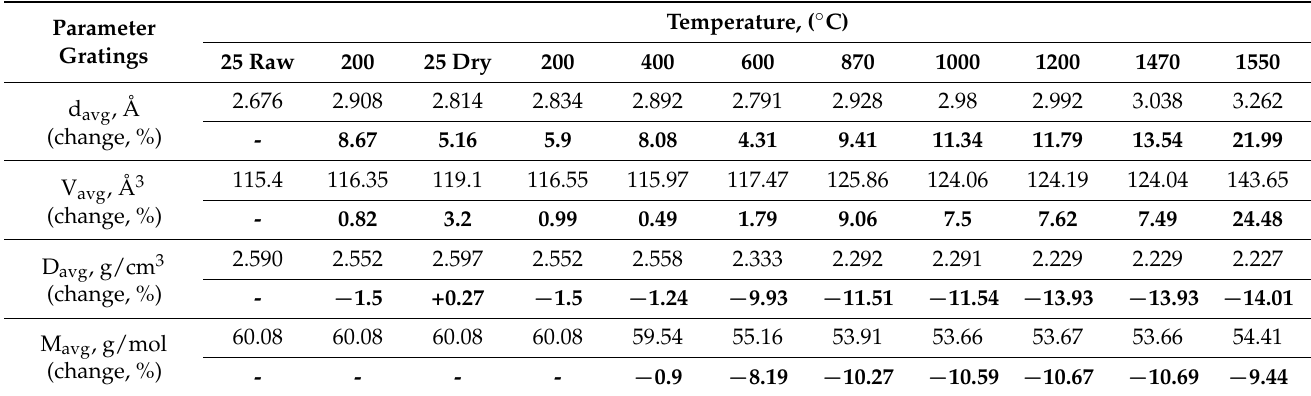
Table 6. Changes in the lattice parameters of quartzite during heating from 25 to 1550 ◦ C with pre-drying at 200 ◦